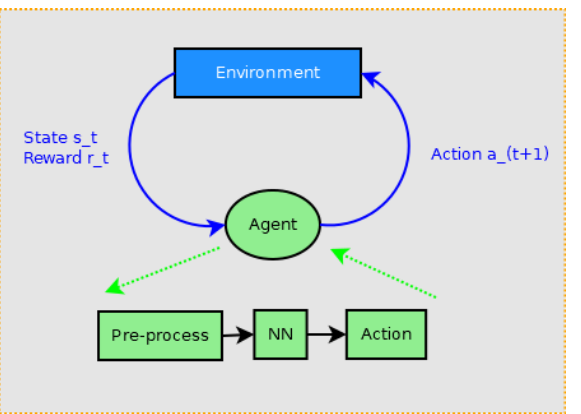
Figure 10. Schematic diagram of (deep) reinforcement learning. An environment (in our case, a stock market) provides a time series of the current state, as well as the current reward for the previous action. That data can be the next increment of the stock price, as well as reward information about the gain or loss due to the last action. In turn, an agent (especially a deep learning agent) processes that new incoming data of state and reward and, combined with the prior history, processes that information to determine a new action, by which it interacts with the environment (e.g., places a buy or sell order or holds shares). The agent is not provided any training data with prior optimal actions, so in that sense, this system is unsupervised. However, the system does provide a concrete reward for each action. Thus, RL stands as a separate branch of learning, distinct from both supervised and unsupervised learning. It has proven promising in many areas